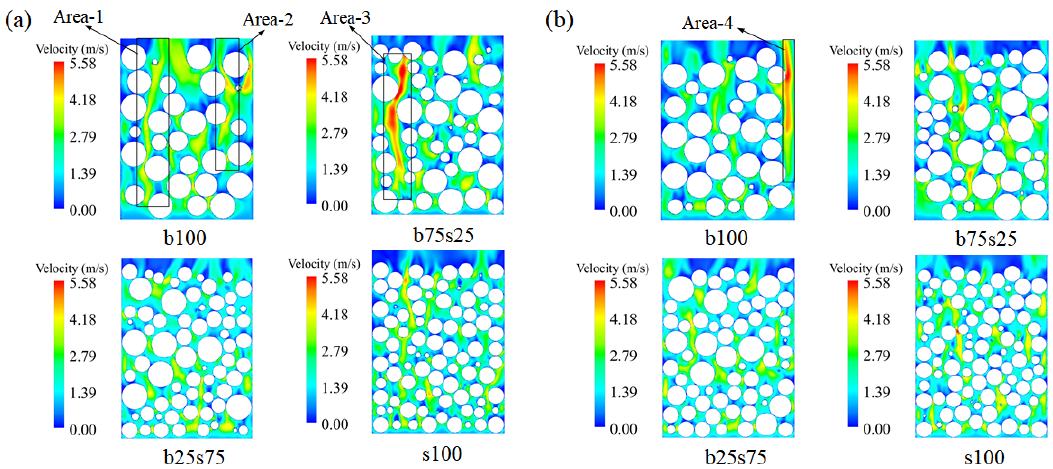
Figure 18. Velocity distributions at different axial cross sections: ( a ) section-4; ( b ) section-5.